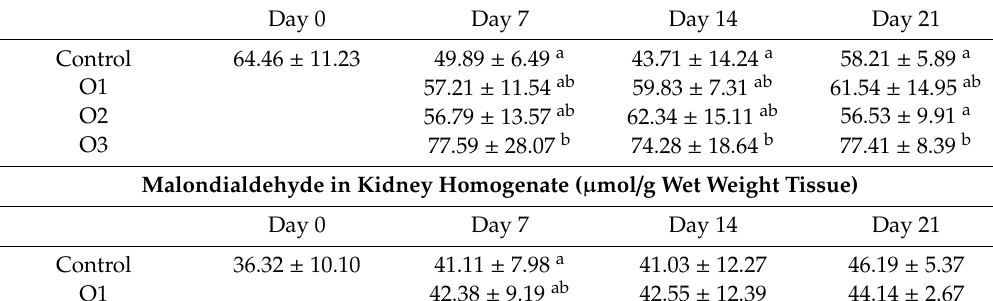
Table 4. E ff ect of Ochratoxin A on malondialdehyde content in liver and kidney homogenates (mean ± SD; n =